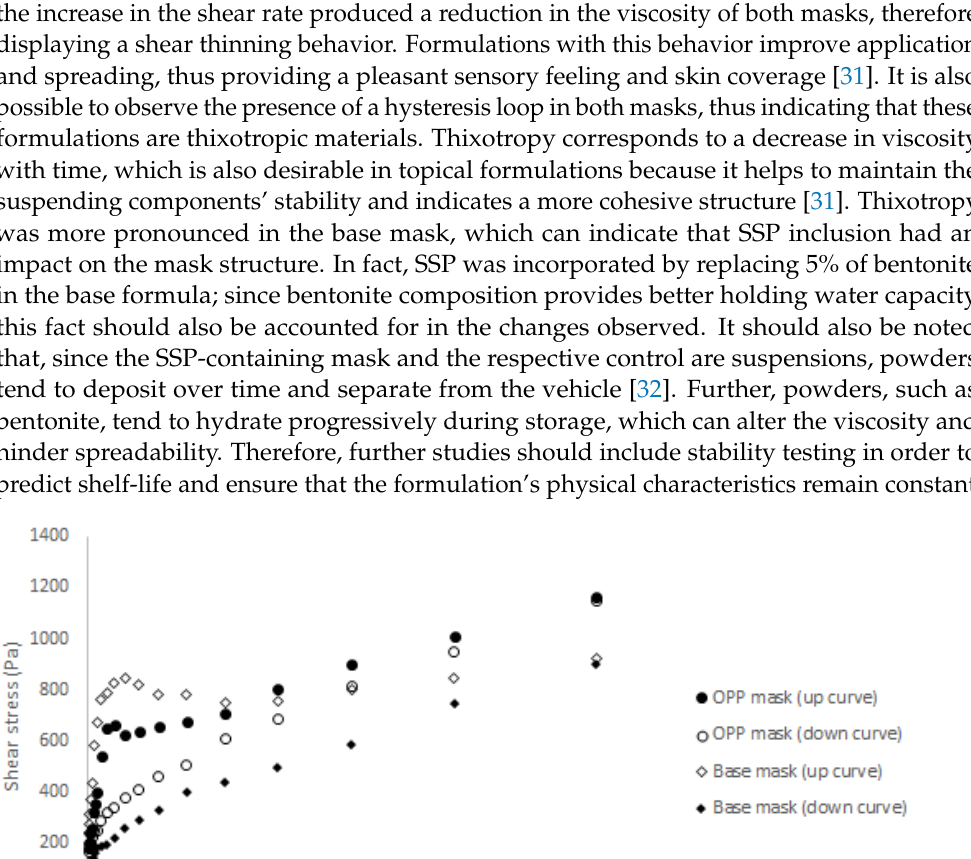
Figure 4. Texture analysis of the facial masks. ( 1 ) mask containing 5% of SSP; ( 2 ) control. Adhesiveness (A( − )) is represented in the bars as mean ± standard deviation. No significant differences were found between samples ( p > 0.05). Figure 5. Texture analysis of the facial masks. ( 1 ) mask containing 5% of SSP; ( 2 ) control. Firmness (Fmax) is represented in the bars as mean ± standard deviation. *, Significant differences ( p < 0.05) were found between samples. 4. Conclusions This work highlights the potential of olive pomace to obtain an innovative ingredient (a semi-solid paste) to be used in facial mask formulations, as a sustainable source of both lipid and polar bioactive compounds. Indeed, the lipid fraction of this new ingredient is a source of antioxidants (such as vitamin E) and hydrosoluble compounds (such as phenolics) that protect the skin against oxidative stress. The 5% SSP-containing mask